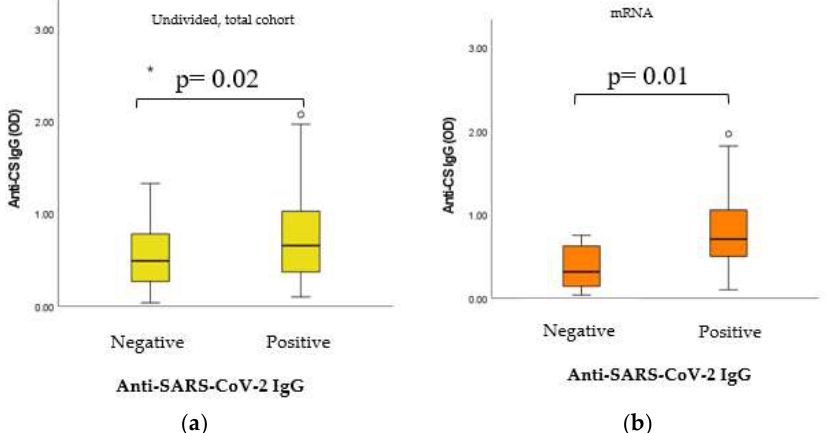
Figure 6. ( a ) Connection between CS IgG titers and anti-SARS-CoV-2 IgG results in the undivided, total sample cohort. ( b ) Connection between CS IgG titers and anti-SARS-CoV-2 IgG results in the mRNA vaccine group. Anti-SARS-CoV-2 IgG qualitative results (positive and negative) were evaluated as per the manufacturer’s instructions. Anti-CS IgG absorbance (OD) results were handled as continuous, non-normally distributed integers and the alterations of titers were considered. In the undivided total cohort, as well as in the mRNA vaccine group, statistically significant positive connection was found between anticitrate synthase IgG levels and the post-immunization anti- SARS-CoV-2 IgG qualitative (positive and negative) results ( p = 0.02 and p = 0.01, respectively). The sample numbers were as follows: ( a ) anti-SARS-CoV-2 IgG negative/positive = 45/132 and ( b ) anti-SARS-CoV-2 IgA negative/positive = 6/62. Total